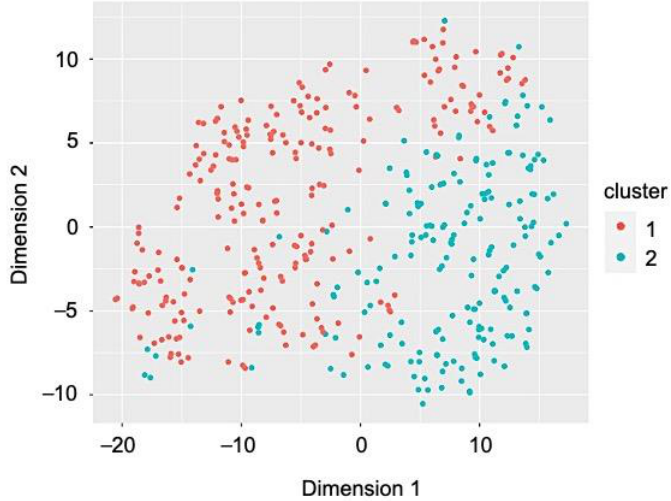
Figure 2. Cluster analysis identified two phenogroups of former smokers. In order to identify phenogroups within the population of former smokers, Gower distance to identify dissimilarity between individuals was calculated and a partitioning around mediods algorithm was used to identify the clusters. The clusters were visualized using t-distributed stochastic neighborhood embedding to reduce dimensionality of the data.